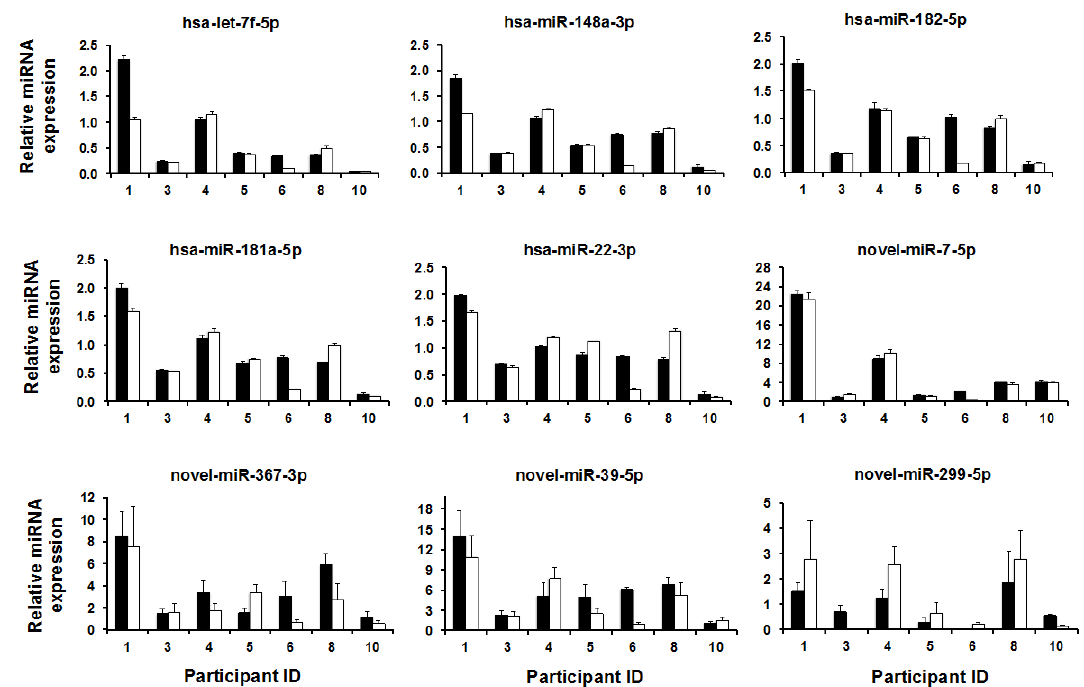
Figure 2. Bar plots showing the expression pattern of the top 5 most highly expressed known miRNAs, and the top 4 most highly expressed novel miRNAs using qPCR. Y axes indicate the expression of each miRNA relative to the endogenous control used (RNU48), whilst X axes indicate Participant ID. A subgroup of 7 mothers was used for qPCR validation. Linear mixed effects modeling showed no significant differences ( p > 0.05) in expression of these known and novel miRNAs between pre- and post-feed milk samples for each mother. novel-miR-299-5p was not detected in sample ID 6 (pre-feed milk) and in sample ID 3 (post-feed milk).